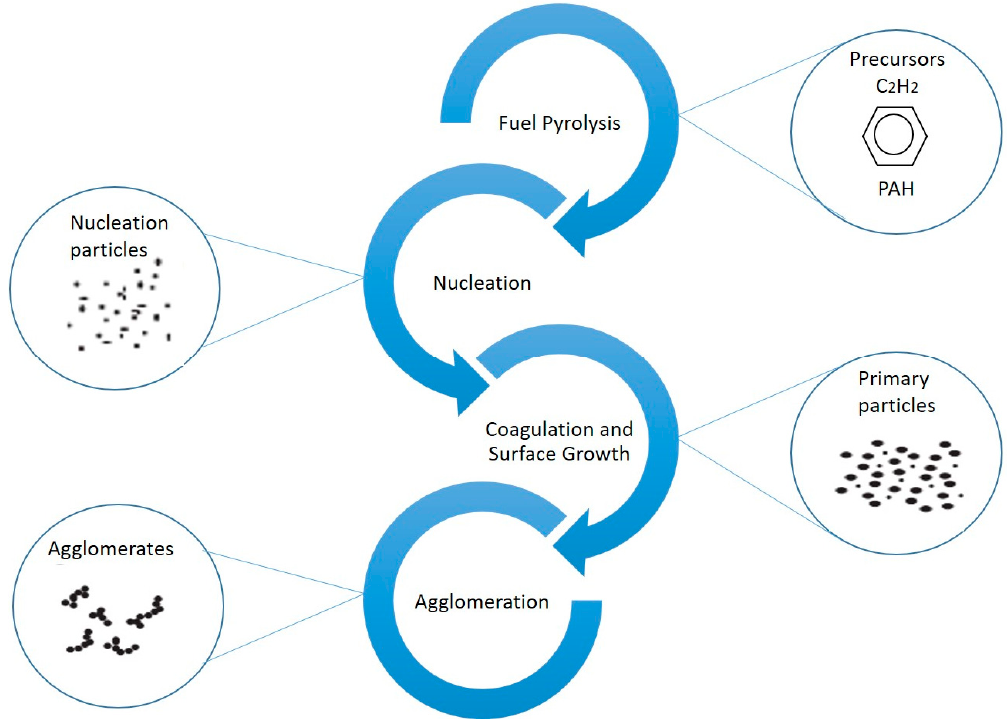
Figure 1. Steps involved in soot formation process.